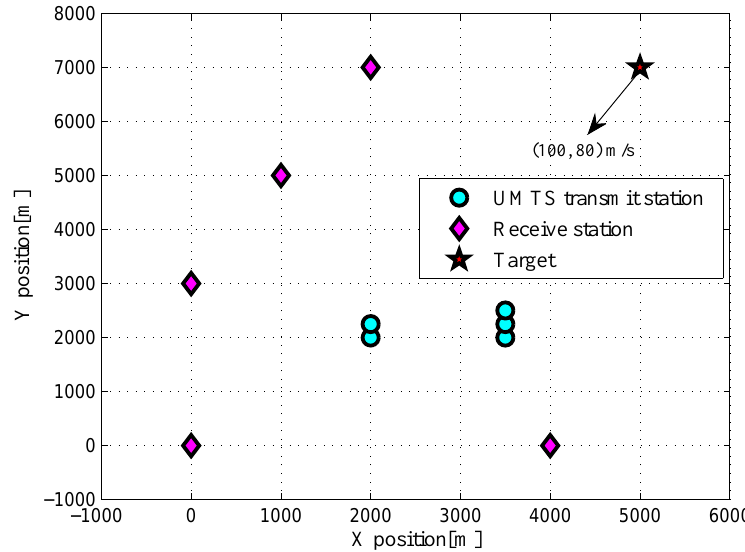
Figure 1. Simulated multistatic 2D scenario with locations of transmit stations, receive stations and